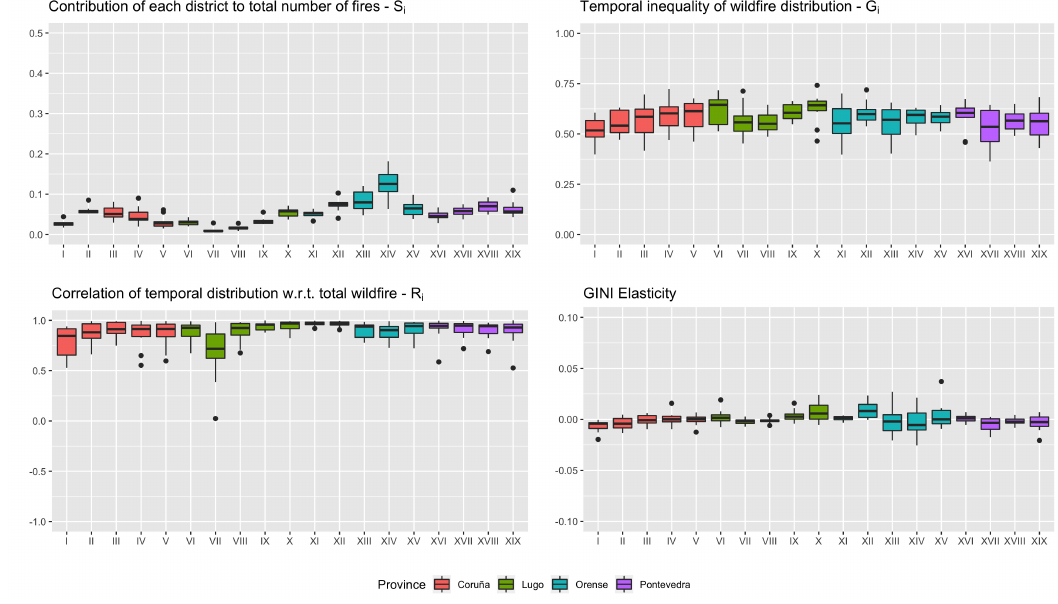
Figure 9. Temporal Gini decomposition of the number of wildfires per forest